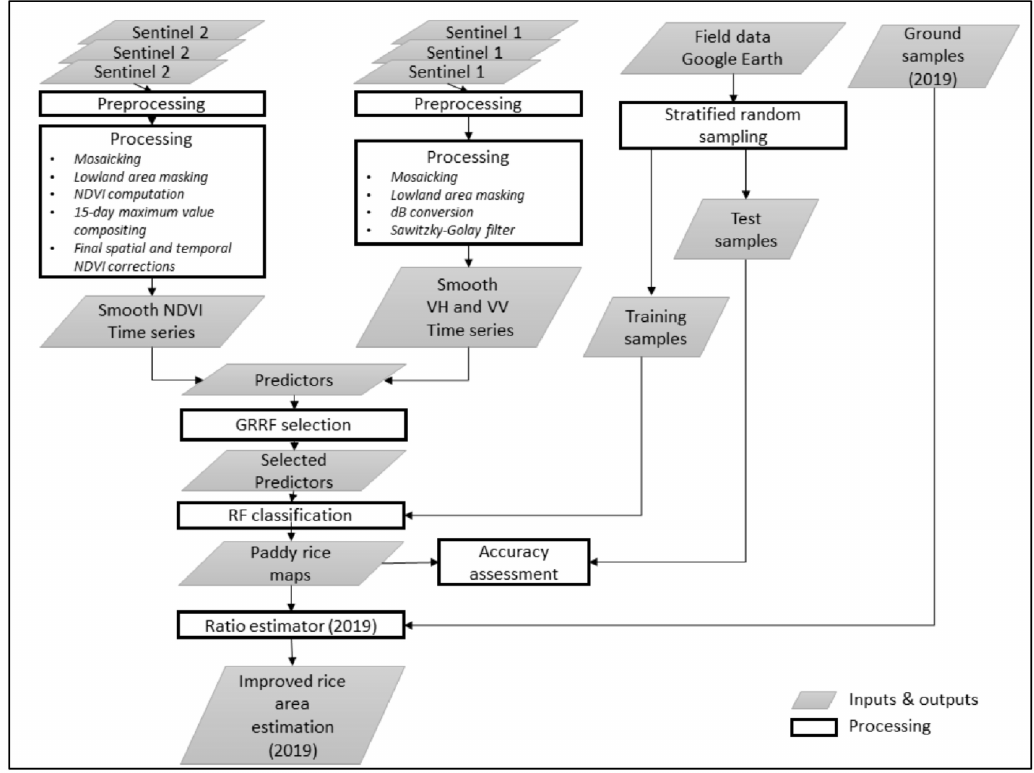
Figure 3. Overview of the study